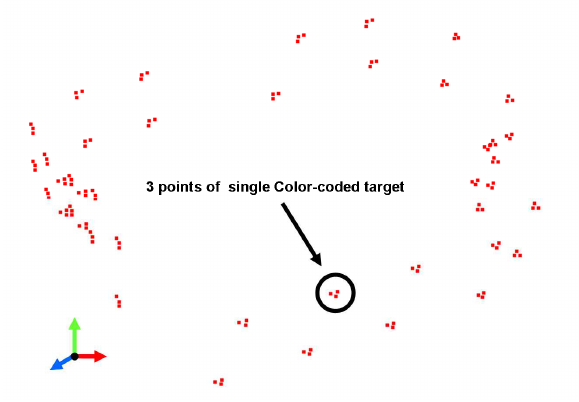
Figure 4. Extracted 3D coordinates of